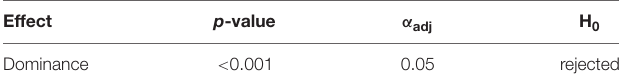
TABLE 6 | The results from the sequential Bonferroni correction of F tests for female faces of Experiment 2.